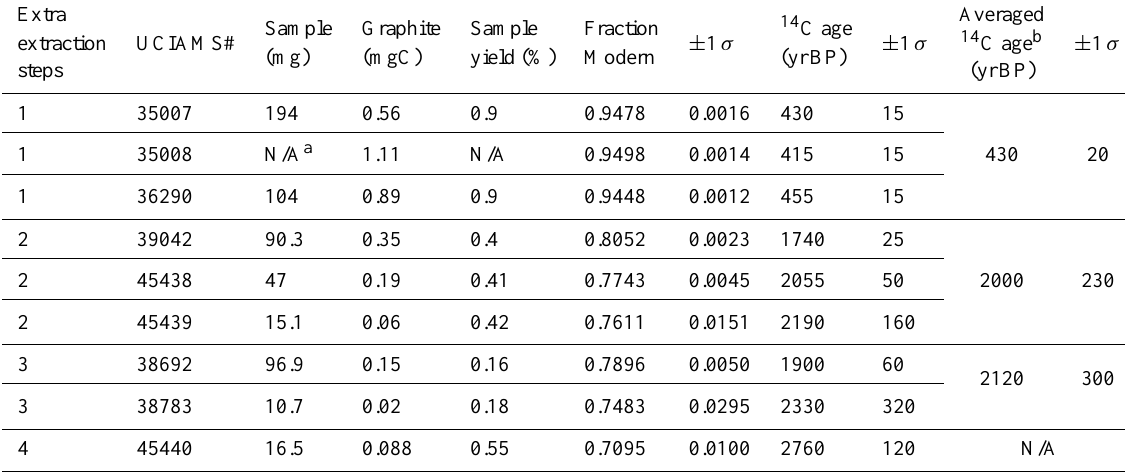
Table 1. Radiocarbon results shown are from several aliquots of a large soil phytolith concentrate (Kandara, described in Santos et al., 2010a). The PhytC was originally assumed to have a “modern” signal (decades or a few hundred years old), as the phytolith assemblage reflects the current vegetation (Bremond et al., 2005). After the first chemical phytolith extraction was performed, following the Kelly et al. (1991) phytolith extraction protocol for soils, subsamples from this phytolith pool were repurified (Santos et al., 2010a) either by baking and/or by extra wet oxidation steps, as illustrated in Fig. 1. Radiocarbon concentrations are given as fraction modern C and conventional 14 C age (yrBP). Mass balance blank subtractions have been applied to samples using the quantified blank data and formulae presented in Santos et al. (2007). Table adapted from Santos et al.